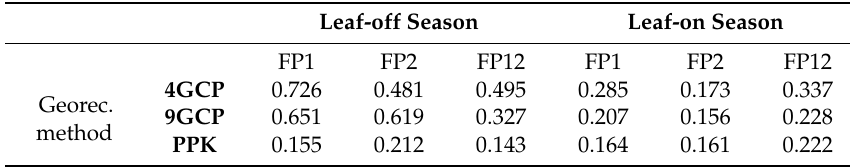
Table 6. Vertical root mean square errors (RMSE z ) for point positions acquired on point clouds (in meters).